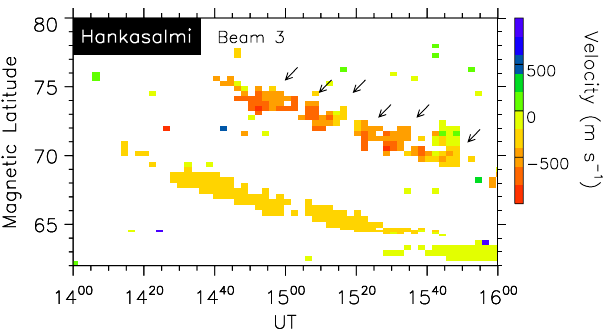
Fig. 10. Latitude-time-velocity plot of the observations from beam 3 of the Hankasalmi radar showing signs of PMRAF-like signatures in the dusk sector